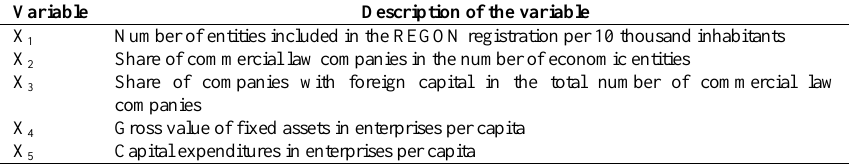
Table 1. The set of diagnostic variables for NUTS 3 regions